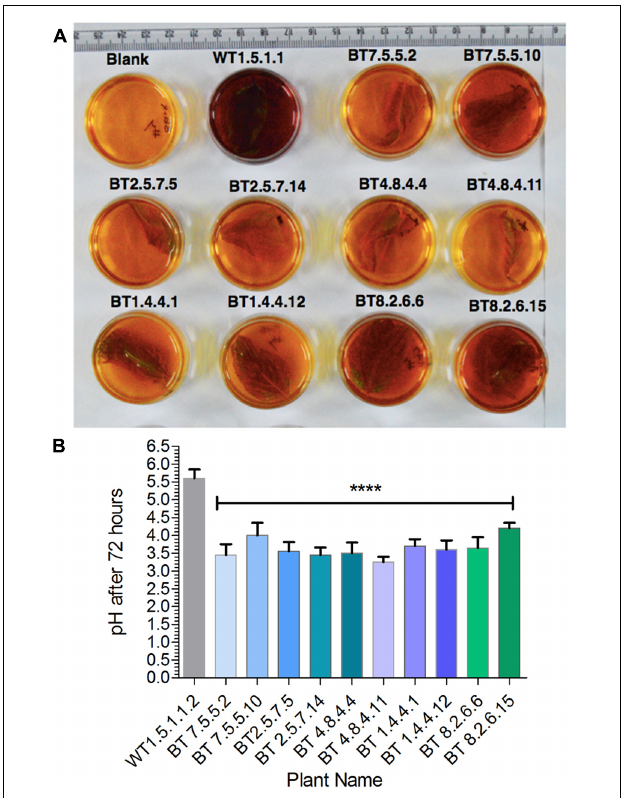
FIGURE 4 | Screening of transgenics by CPR assay. (A) After incubation in hygromycin-B, transgenic plants developed yellow color with significant difference ( ∗∗∗∗ P < 0.0001) in media pH value as compared to non-transgenic (WT). (B) Bt jute leaf containing media showing pH range of 3.0–4.12.